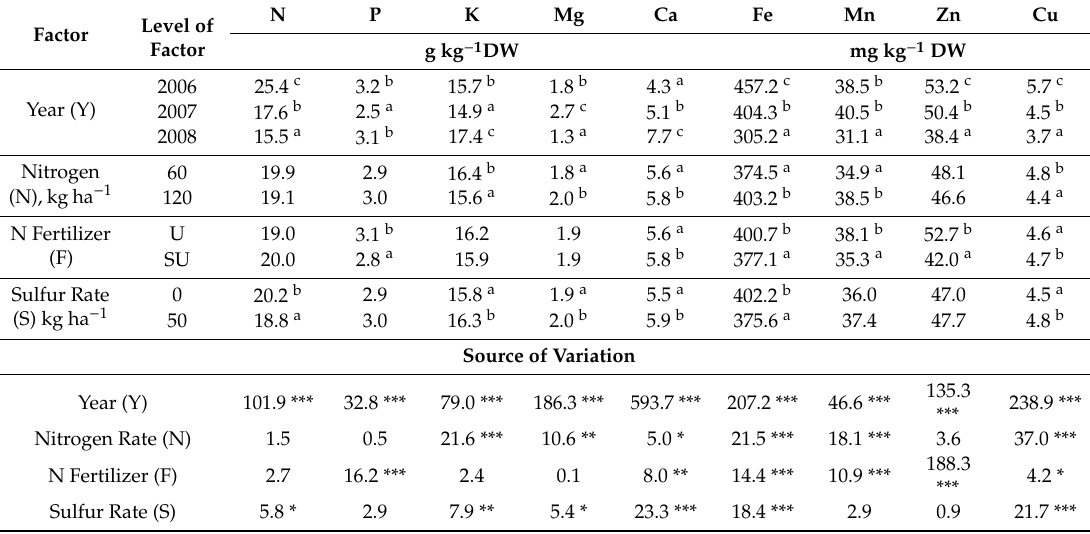
Table 6. Nutrient content in potato stolons and roots at the onset of tuberization (BBCH 39 /